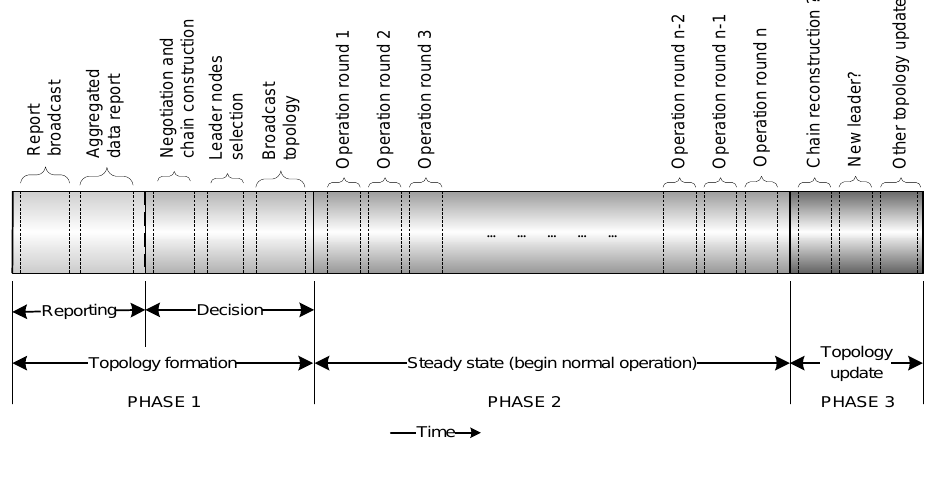
Figure 5. Timeline of the proposed topology.